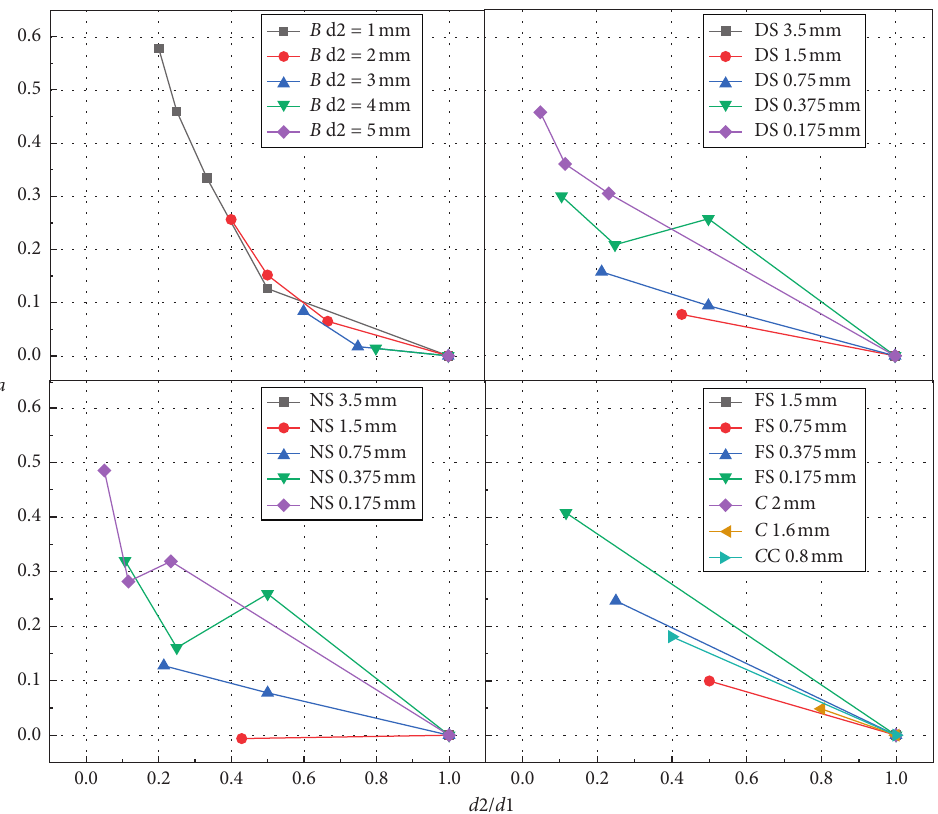
Figure 15: Curves of a and d